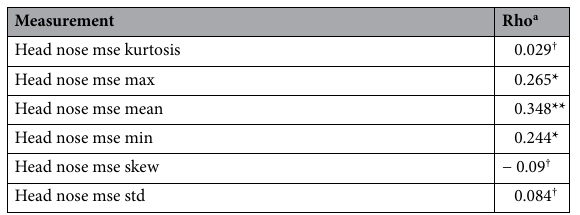
Table 3. Pearson’s correlation coefficients for the head nose mean squared error with the lameness score 0–3 for all 61 cows. a The head nose mean squared error is calculated as the position of the head and nose with relation to the back regression line (outlined in “Back posture analysis” and “Head position analysis”). The indicated probability thus: † P < 0 . 10 , * P < 0 . 05 , ** P < 0 . 01 , *** P < 0 .